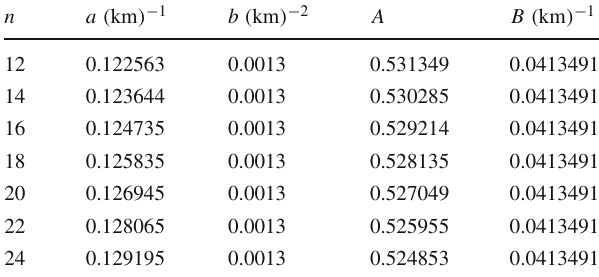
Fig. 1 Variation of metric potentials with radial coordinate for the parameters given in Table 1 Table 1 Values of the constants for different values of n